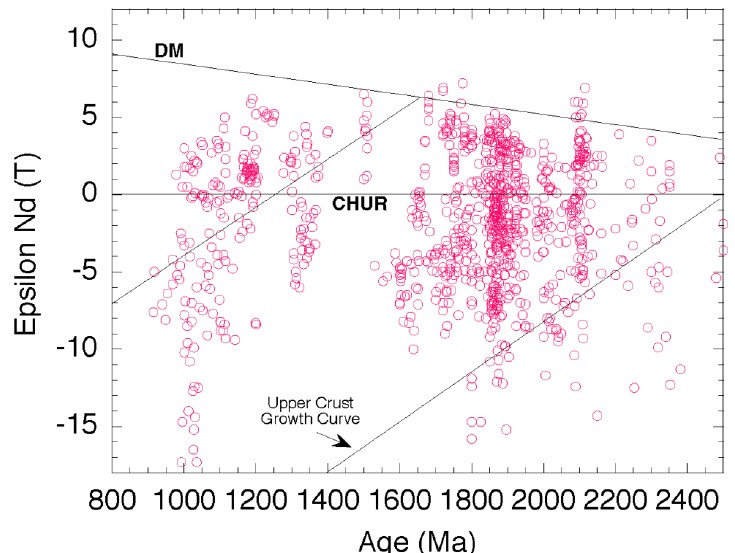
Figure 12. Epsilon Nd(T) versus age for igneous rocks from Proterozoic orogens (updated after Condie [18] from data in Appendix 1). DM, depleted mantle growth curve; CHUR, chondritic uniform